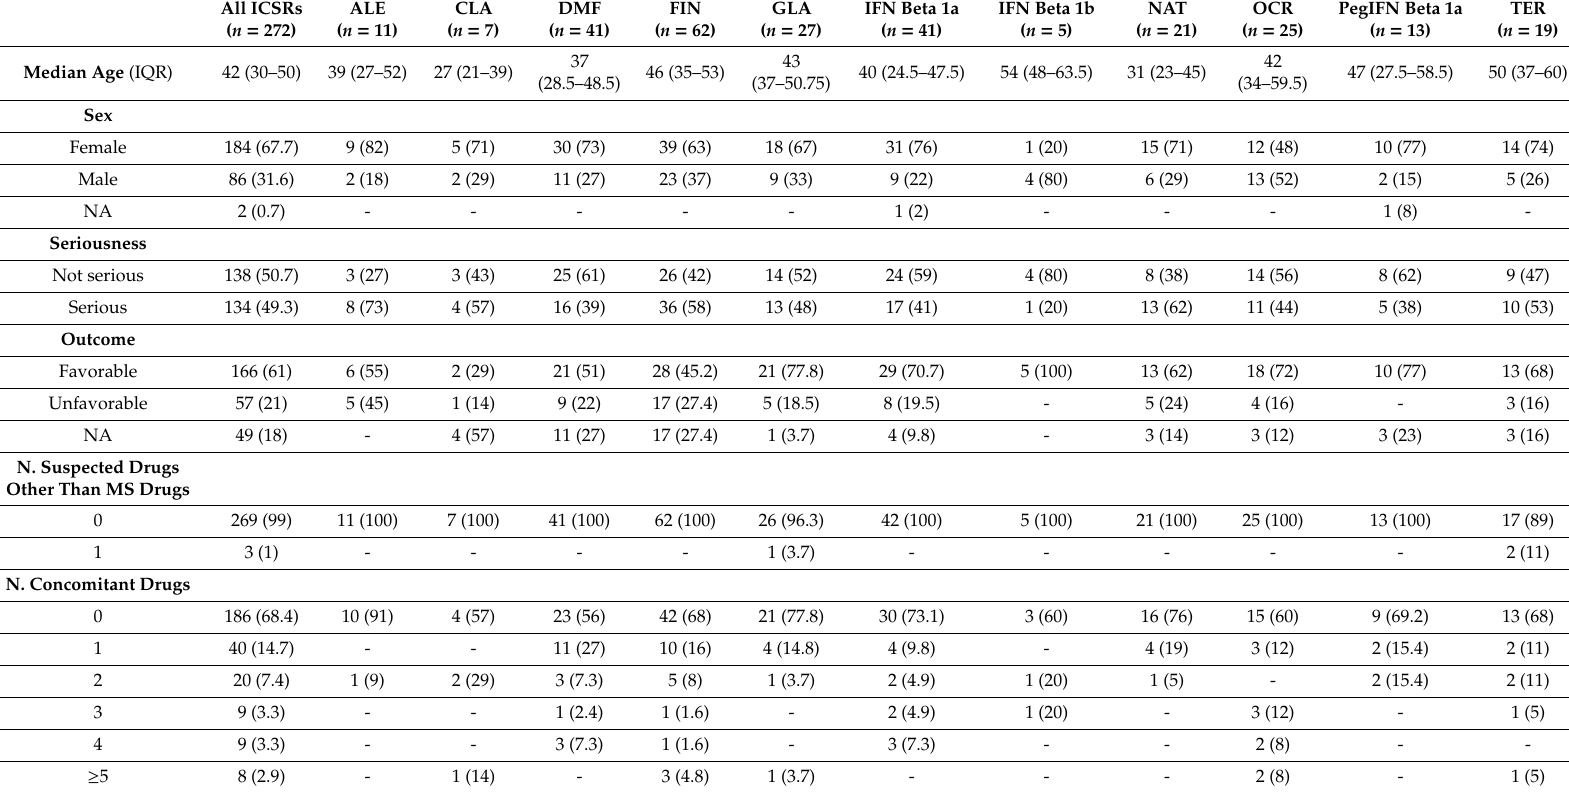
Table 1. Main characteristics of Individual Case Safety Reports (ICSRs) sent to the Rete Nazionale di Farmacovigilanza (RNF) during the first 16 months of the Farmacovigilanza Attiva Sclerosi Multipla (FASM)